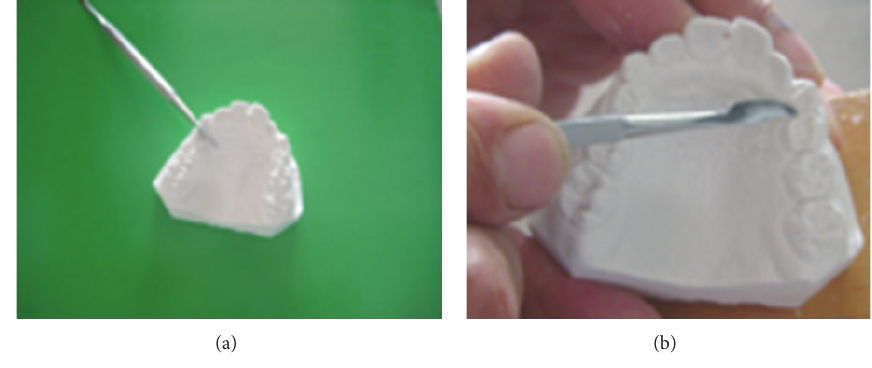
Figure 1: Plaster model and elimination of undercuts.